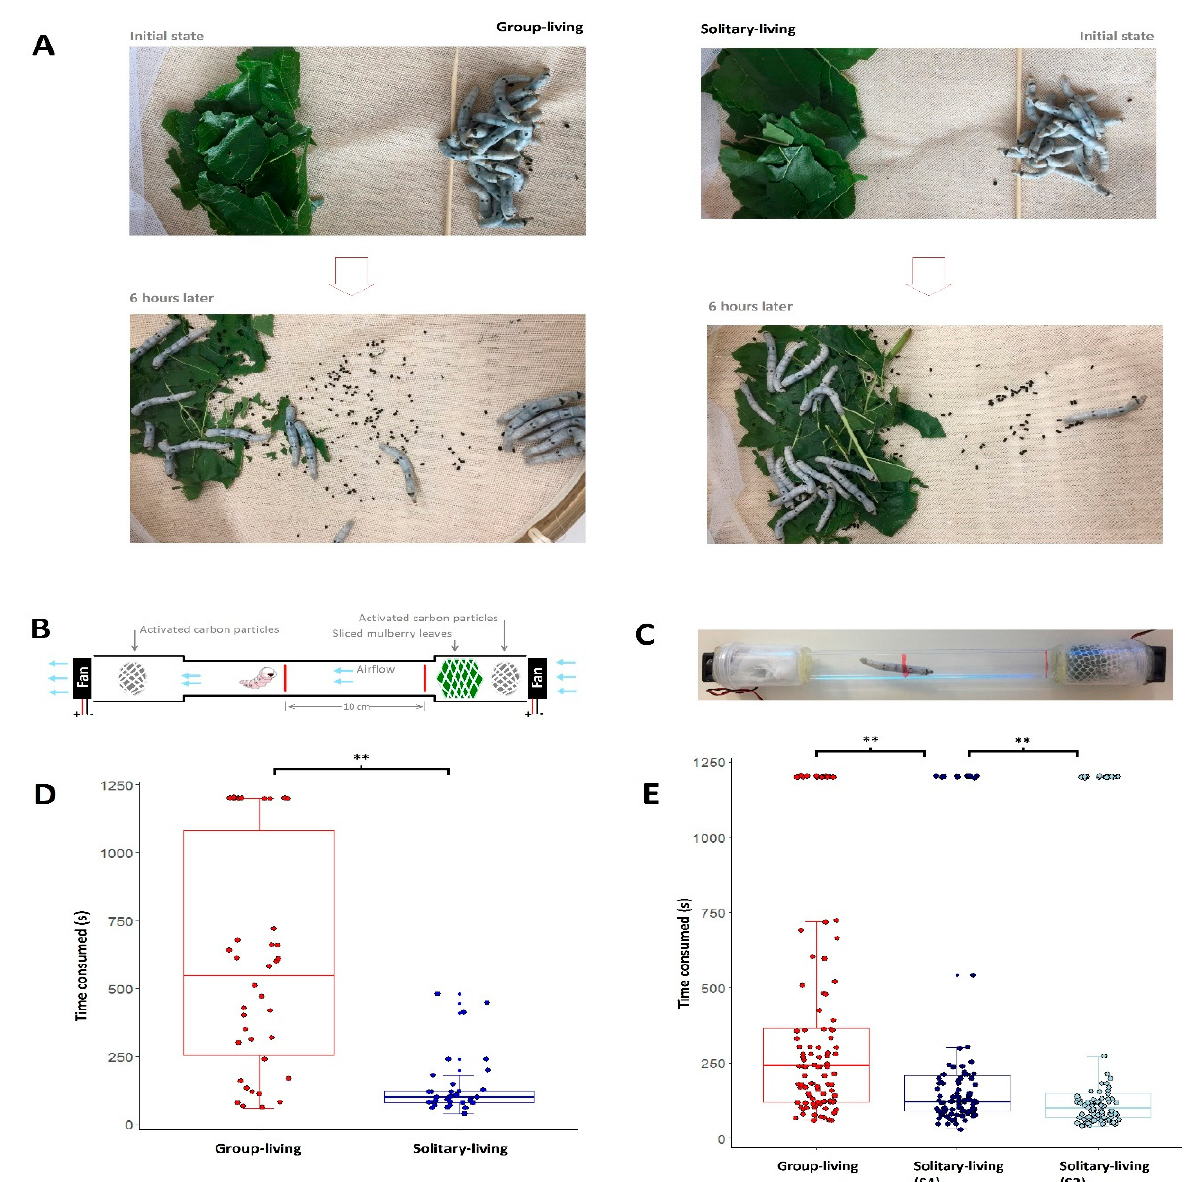
Figure 1. Evidence showing that solitary-living silkworms experienced a loss of body weight com- pared to group-breeding silkworms. ( A ) is a photo showing the difference in appearance of solitary and group-living silkworms in the 3rd day of the 5th instar. ( B ) shows the body weights of solitary (blue) and group-living (red) silkworms from the 1st day to the 3rd of the 5th instar. The weights on the 1st day of the 4th instar acts as a control for comparison. ( C ) is the comparison of the body weight of group-living (red), S4 (solitarily bred as early as the 1st day of the 4th instar, dark blue) and S3 (solitarily bred as early as the 1st day of the 3rd instar, light blue) solitary-living silkworms. Weights are recorded from the 1st day to the 4th day of the 5th instar. ( D ) is the comparison of the weight of dungs between solitary (blue) and group-living (red) silkworms. The weight of the dungs of six silkworms on the 3rd day of the 5th instar are weighed and recorded each time. In B to D, ‘**’ denotes p -value < 0.01. Statistics are performed by Wilcox test.